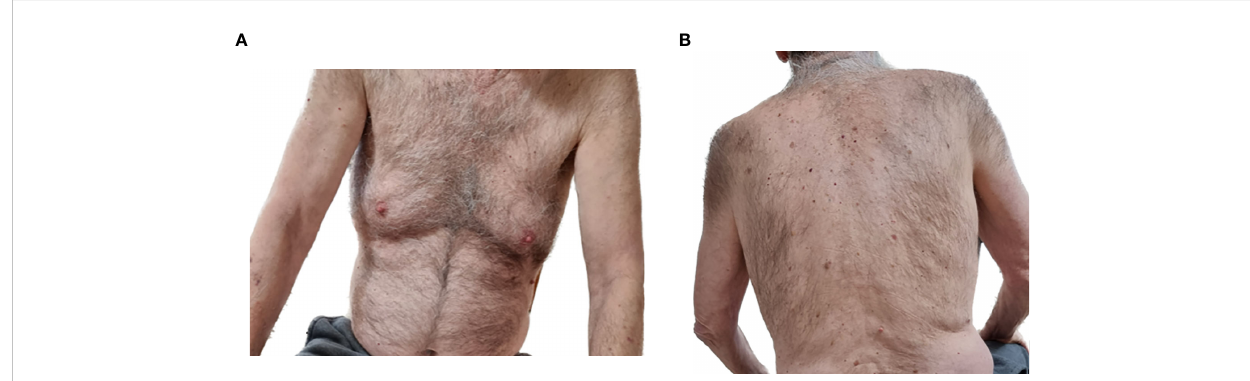
FIGURE 2 Clinical remission of the bullous pemphigoid three months after the third rituximab infusion in the index case, the 8 th patient. No evident skin lesions on the (A) front torso or (B) back